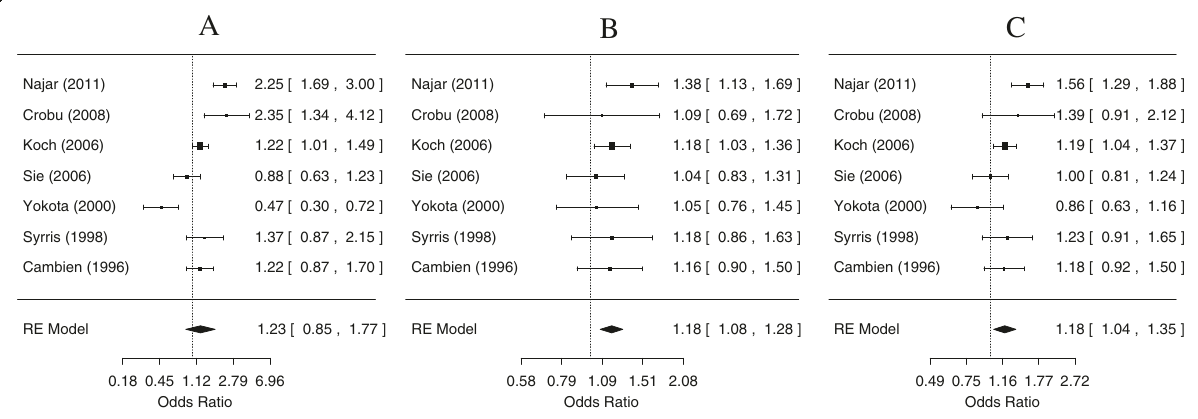
Figure 2 Meta-analysis for coronary heart disease risk depending on the rs1982073 (868 T/C) polymorphism in the TGFB1 gene. ORs and corresponding 95% confidence intervals (CIs) are shown. A . Comparison of the homozygous CC genotype with the wild type TT genotype (random-effect model, p =0.26); B . Comparison of the heterozygous TC genotype with the wild type TT genotype (random-effect model, p =0.0002); C . Comparison of the CC+TC genotype with the wild type TT genotype (random-effect model, p